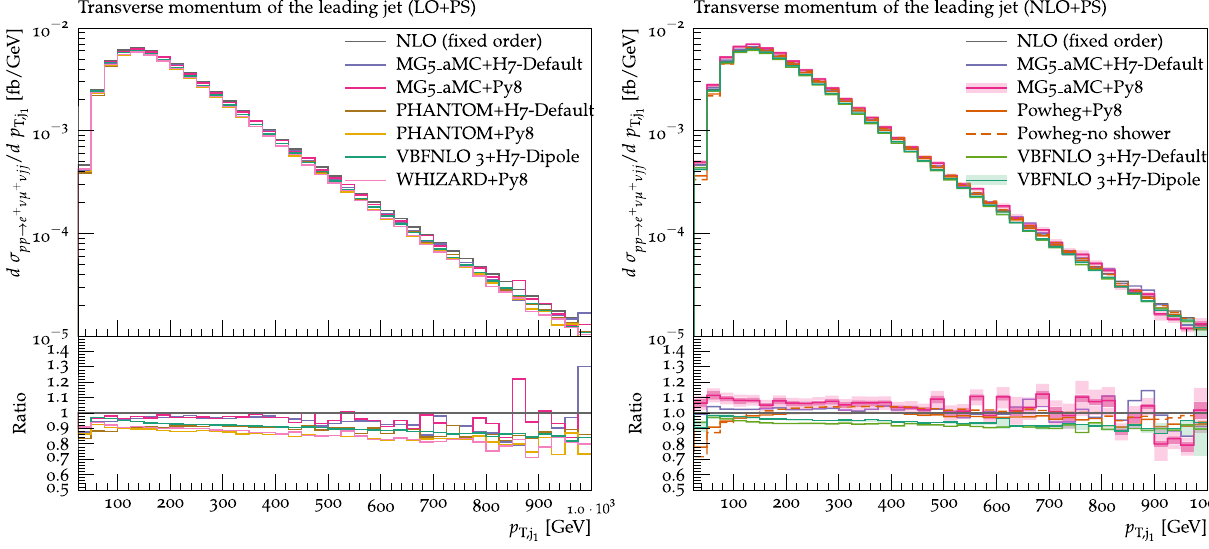
Fig. 16 Differential distribution in the transverse momentum of the hardest jet from predictions matched to parton showers, at LO (left) or NLO (right) accuracy (upper plot), compared with the fixed-NLO result computed with VBFNLO (lower plot). At NLO+PS accuracy, for VBFNLO + Herwig7- Dipole , the three-point scale uncertainties are